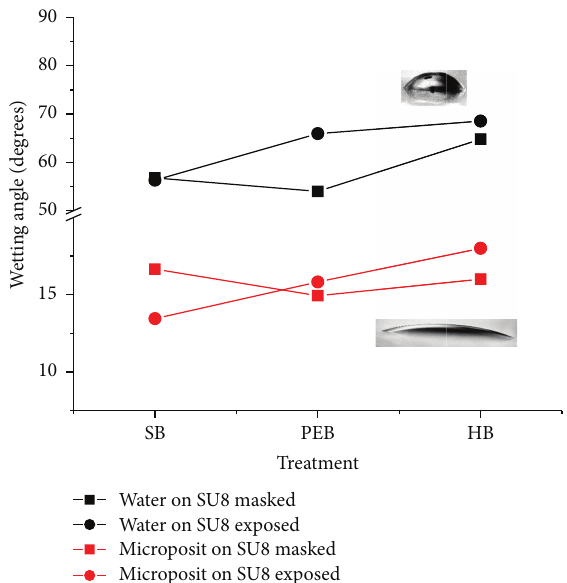
Figure 3: Contact angle for water and Microposit on SU-8 2050.